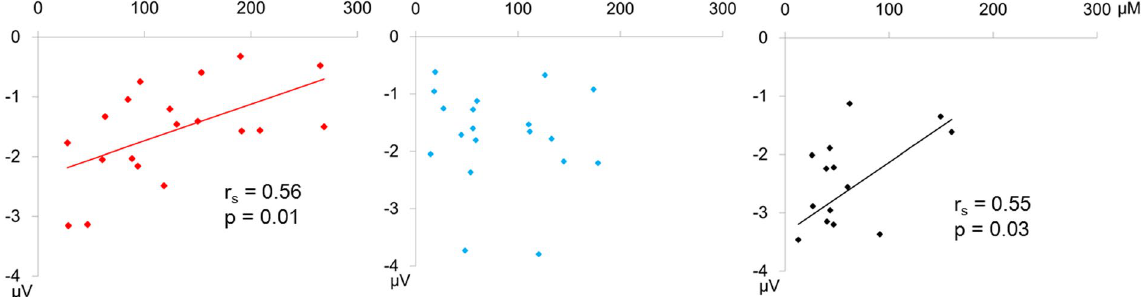
Figure 3. Correlations between duration mismatch negativity (dMMN) amplitude and the plasma level of glutamate at the electrode FCz in first-episode psychosis (FEP; left), ultra-high risk (UHR; middle), and healthy controls (HC;